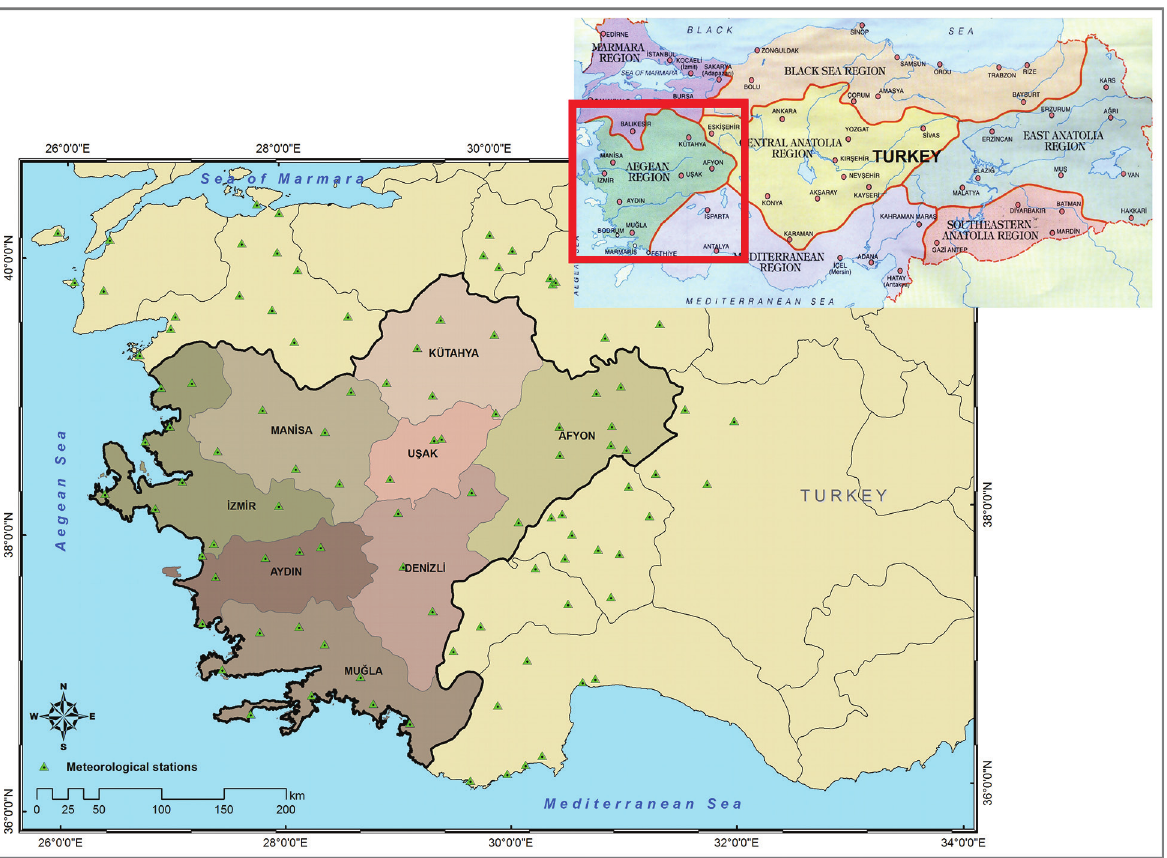
Figure 1 - The location of the study area (The Aegean Region, Turkey) and spatial distributions of the meteorological